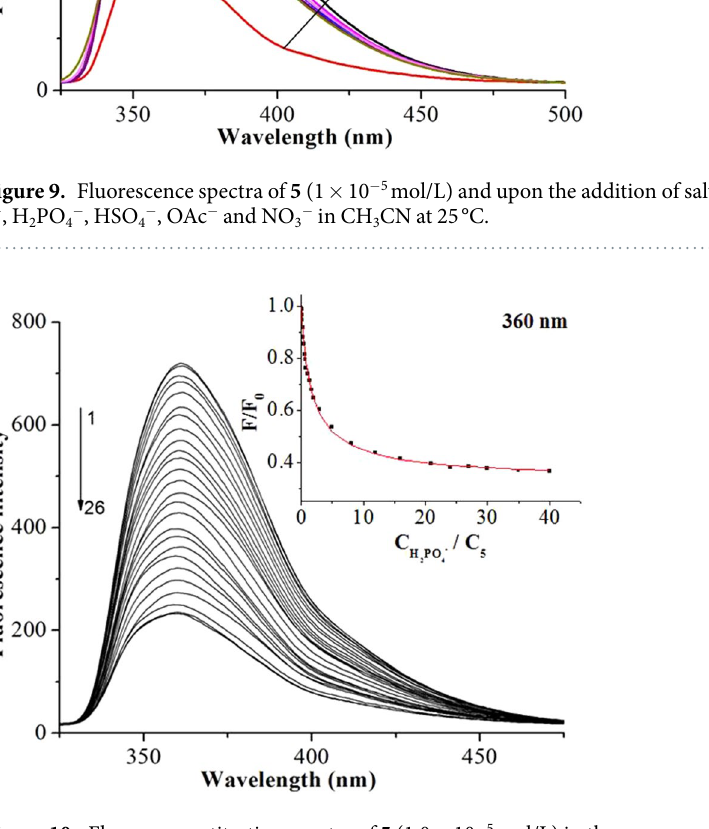
(PET) process from the imidazole ring to the binaphthyl in the presence of H 2 PO 4 − 20, 71–73 . In UV/vis experiment (Figure S16), the receptor 5 (1 × 10 − 5 mol/L) exhibited an absorption peak at around 220–245 nm in acetoni- trile at 25 °C which originated from the E 1 absorption band of binaphthyl. With the addition of H 2 PO 4 − , the absorption peak of 5 at 220–245 nm decreased obviously. It can be concluded that 5 had the ability to selectively discriminate H 2 PO 4 − from other anions. Figure 10 demonstrated the fluorescence spectra of 5 (1 × 10 − 5 mol/L) in the presence of different amounts of H 2 PO 4 − , in which the fluorescence intensities at 360 nm decreased grad- ually with the increasing concentration of H 2 PO 4 − . In the inset of Fig. 10, when the ratio of C H2PO4 − /C 5 was no more than 8:1, the fluorescence intensity remarkably decreased with the enhancement of H 2 PO 4 − concentration. Changed the ratio from 8:1 to 24:1, the decreasing tendency of the fluorescence intensity slowed down. When the ratio exceeded 40:1, higher C H2PO4 − did not lead to further decrease of emission. The stability constant Ks for 5 ·H 2 PO 4 − was calculated as 1.03 × 10 5 M − 1 (R = 0.991) by using the nonlinear least-square analysis 74, 75 :